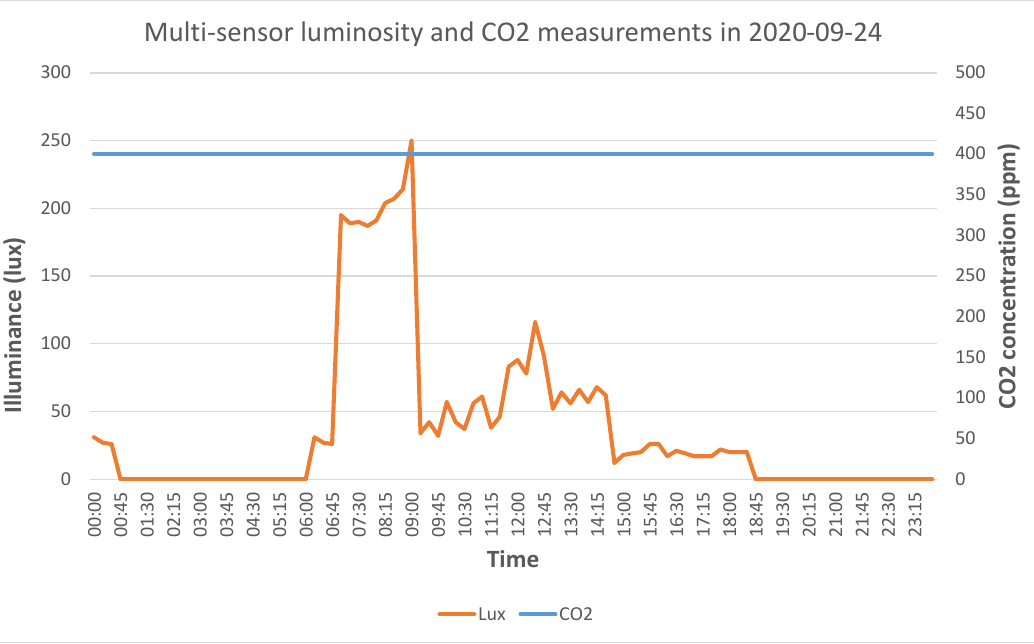
Figure 7. Multisensor measurements for luminosity and CO 2 on 24 September